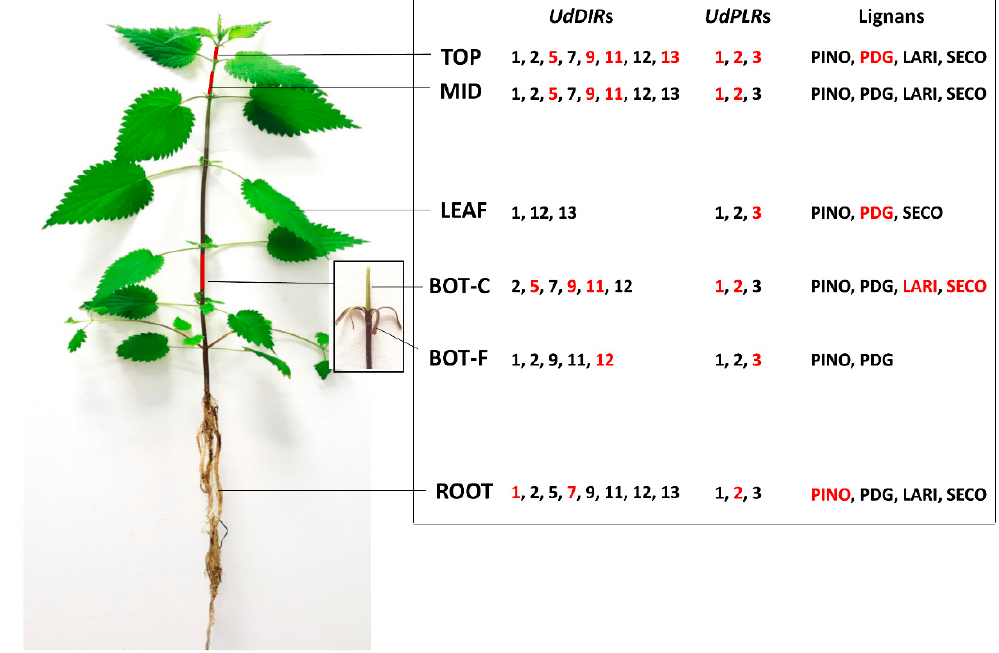
Figure 7. Drawing summarizing tissue/organ-specific gene expression and the lignan classes detected. Genes that are highly expressed in the specific tissue are indicated in red, as well as the highly abundant lignans. PINO, pinoresinol; PDG, pinoresinol diglucoside; LARI, lariciresinol; SECO, secoisolariciresinol.